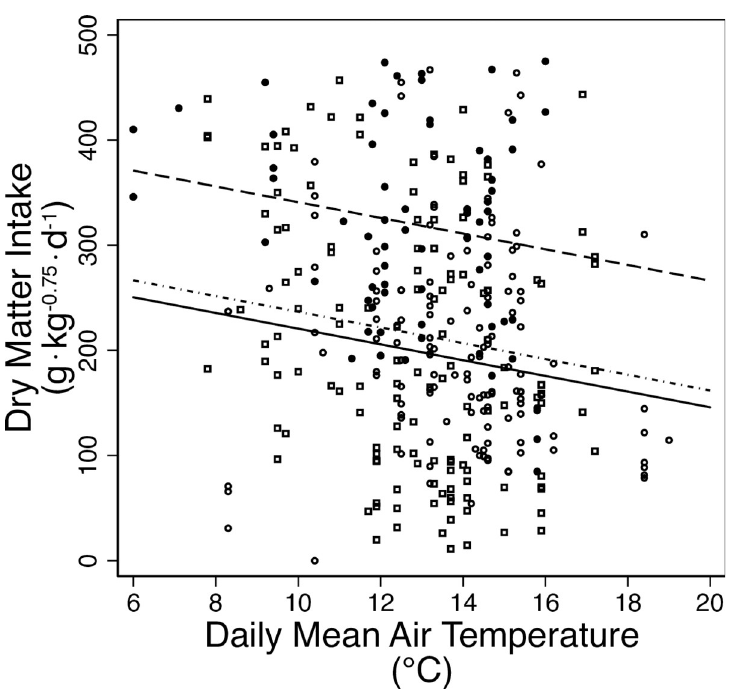
Fig 3. Intakes. Estimated daily dry matter intake (g•kg -0.75 •d -1 ) of female moose from indigestible marker dosed in summer (May–August; ordinal day 140–240) at the Kenai Moose Research Center, Kenai Peninsula, Alaska, USA in 2014–2016. Symbols are observed data. Lines are predicted relationships from mixed model regressions of intake against mean daily air temperature (˚C) for each year. Key: 2014 –solid line and solid circle; 2015 –dashed line and hollow circle; 2016 –dash-dotted line and hollow